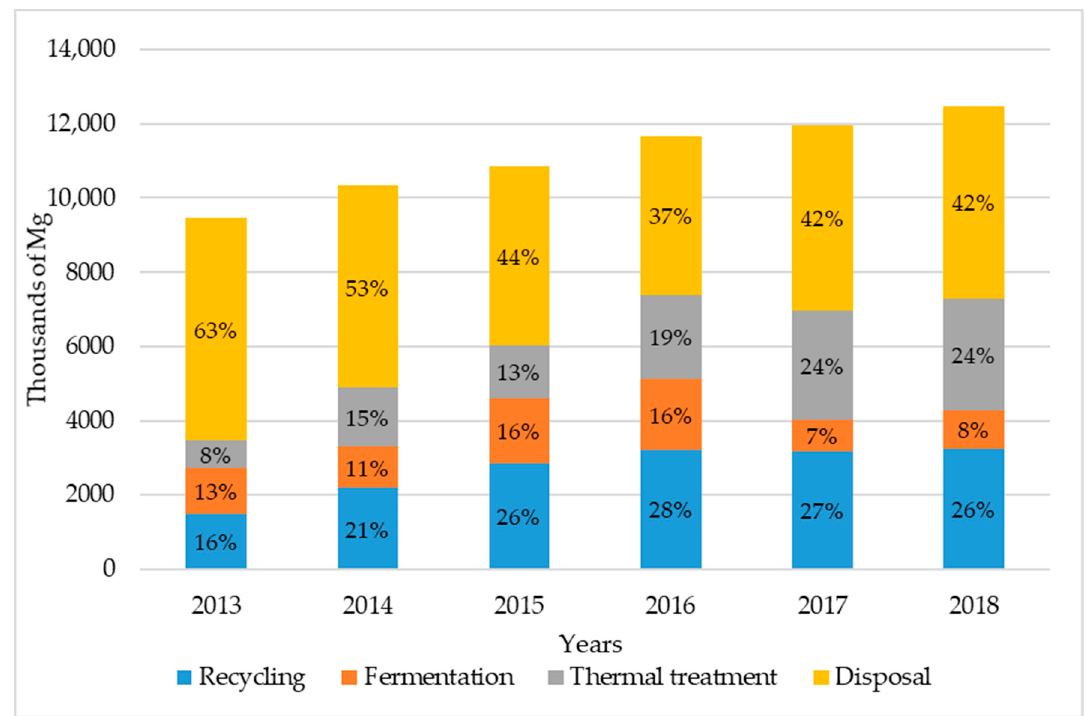
Figure 1. Municipal solid waste management in Poland in 2013–2018 [4]. SARS-CoV-2 coronavirus is a new type of virus and belongs to the beta-coronavirus group. It is very similar to SARS-CoV. The coronavirus is spherical in shape with a diameter of about 130 nm. Due to its small size, it can remain airborne for a long time and can easily pass through many protective materials [6]. Coronavirus is a pathogen different from other viruses, bacteria, and pathogenic microorganisms known to the waste management industry on a daily basis. Figure 2 shows the persistence of coronavirus on the surface of different wastes [7].